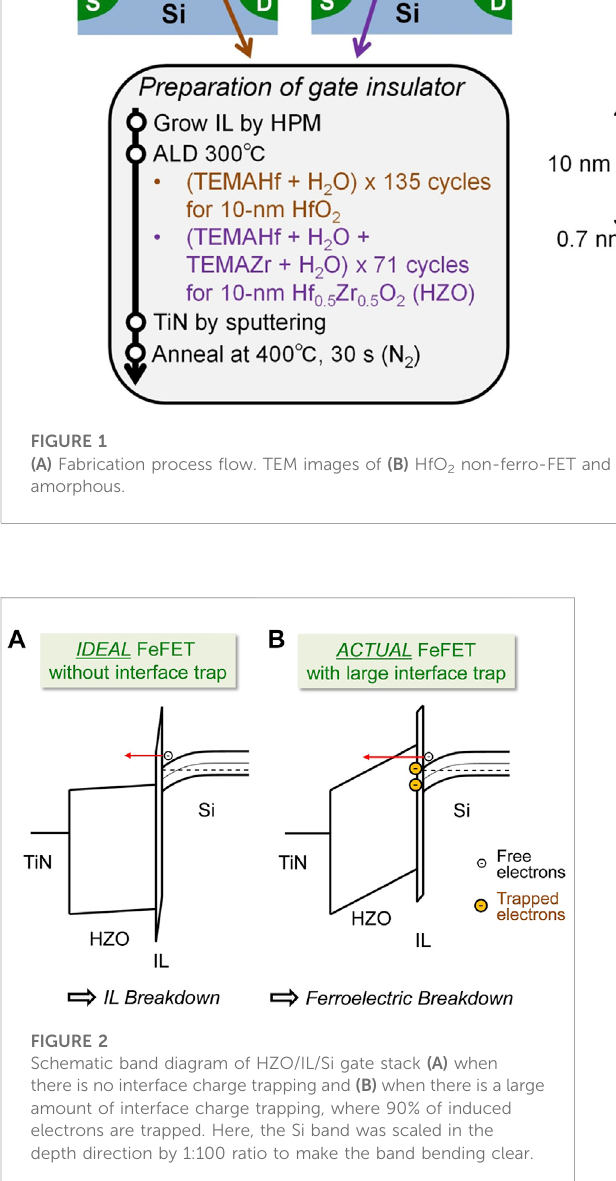
charges near the HZO/IL interface electrically screens the polarization and suppresses the electric fi eld across the IL (Toprasertpong et al., 2019; 2022c). Figure 2B depicts the band diagram with ferroelectric polarization of 10 μ C/cm 2 and 90% (Ichihara et al., 2020) of induced electrons are trapped at the HZO/IL interface. It can be seen that the band of HZO is not at such a low energy position. This fact indicates that electrons have